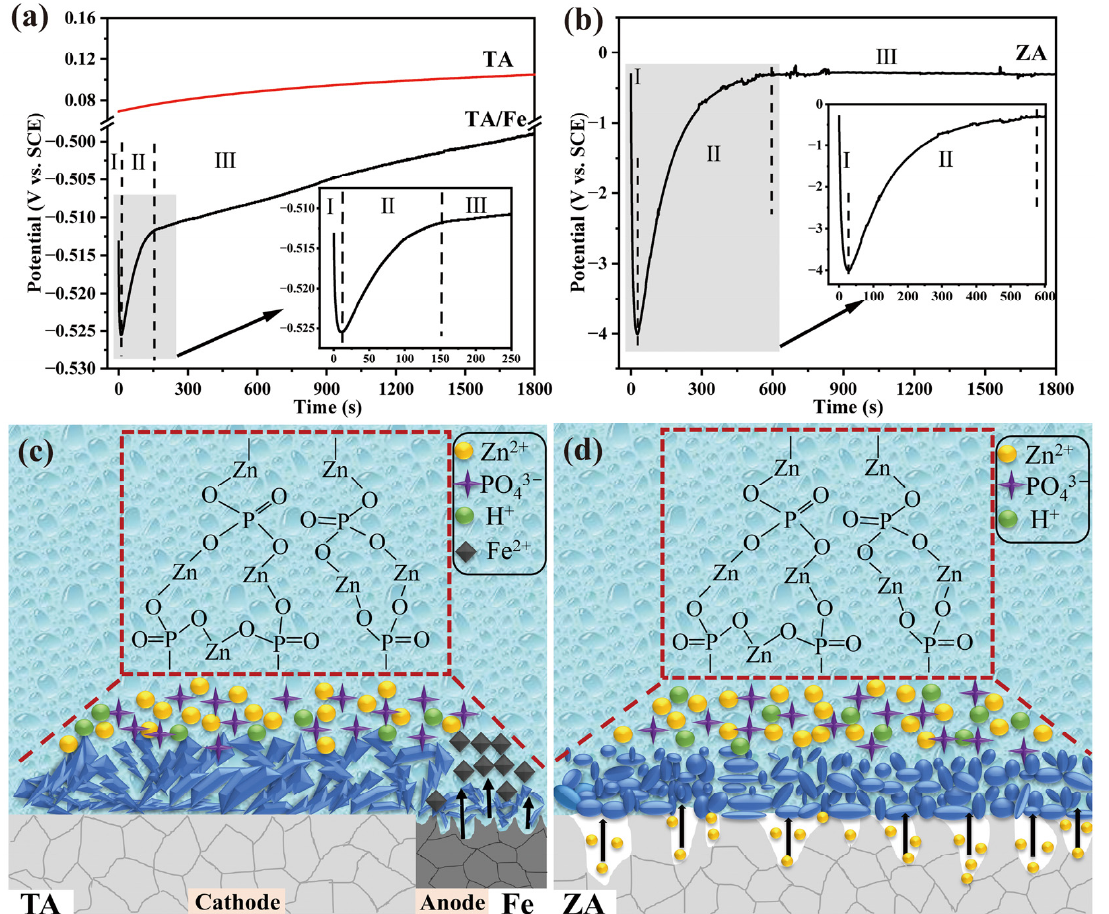
Figure 7. The potential-time curves of ( a ) TA and ( b ) ZA during the coating deposition in the phosphate chemical-conversion solution and a schematic diagram of the ZnP coating formation on ( c ) TA and ( d ) ZA substrates.